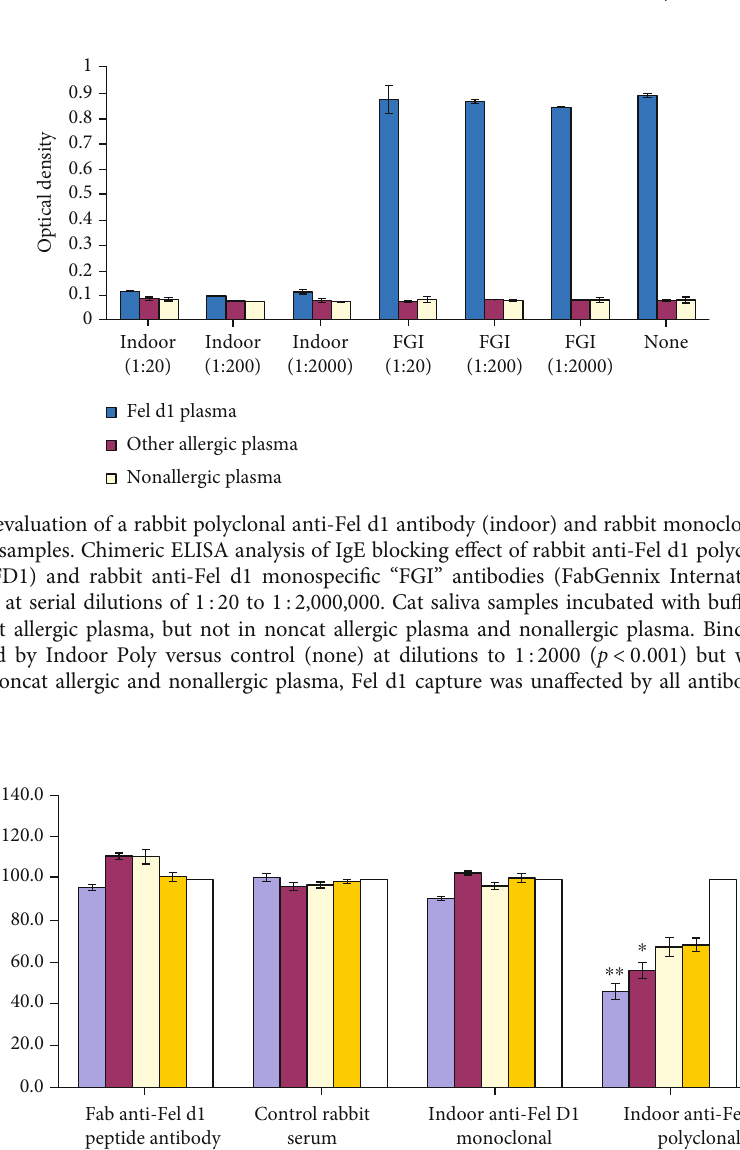
Puri fi ed Fel d1 has been shown to induce dose-dependent IgE-mediated histamine release in blood samples from cat- allergic individuals [25]. Fel d1 levels can vary in cat saliva; therefore, we repeated the RBL assay using saliva from multiple cats. As before, the Indoor Poly antibody dose- dependently inhibited mediator release, at dilutions to 1 : 2000 ( p < 0 : 001 ) (Figure 3).